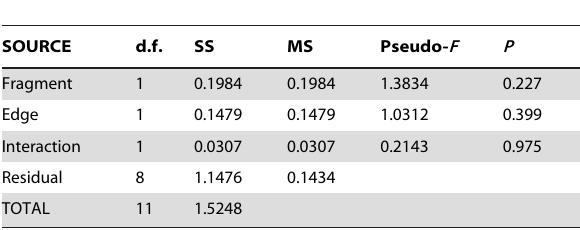
Table 2. Two-way PerMANOVA testing whether bird communities (28 species) differ between forest edges and interiors in habitat fragments and intact-forest sites.